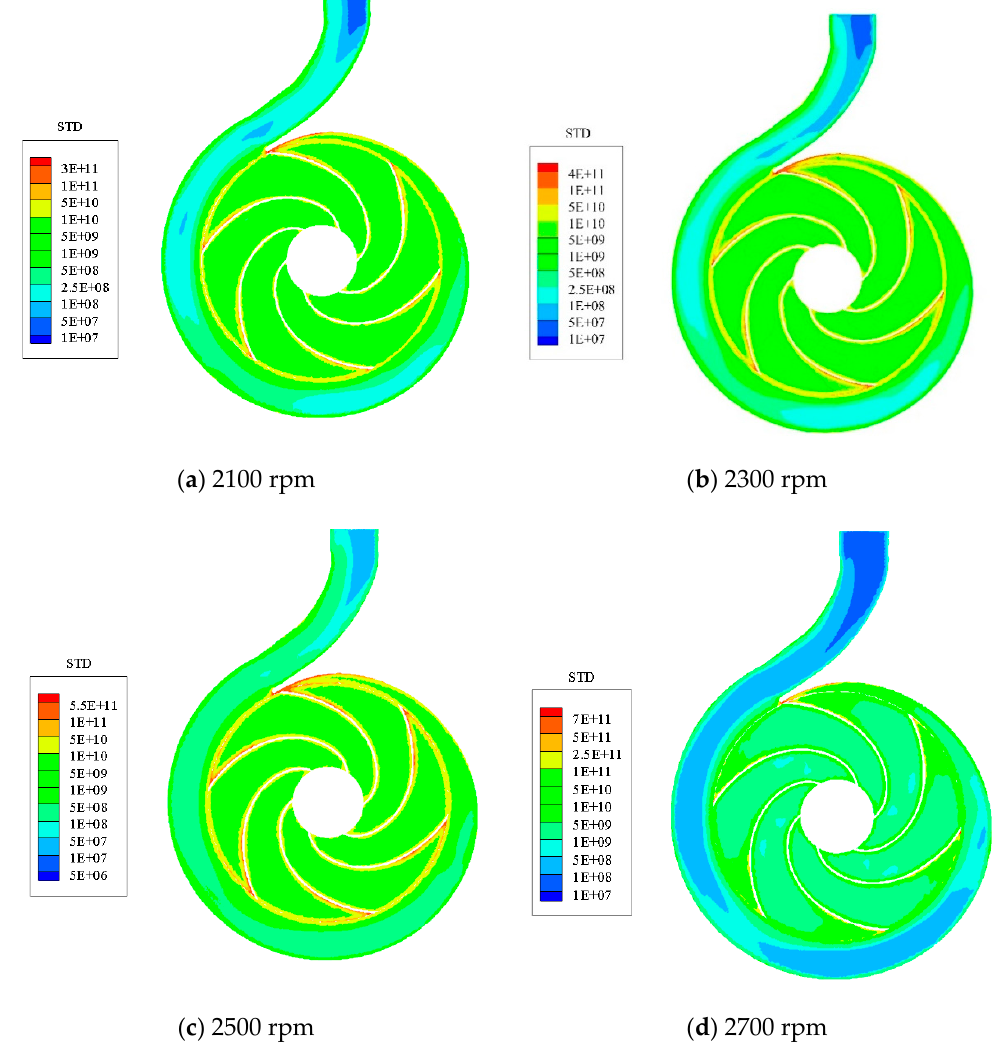
Figure 11. The distribution characteristics of STD under various rotational speeds.